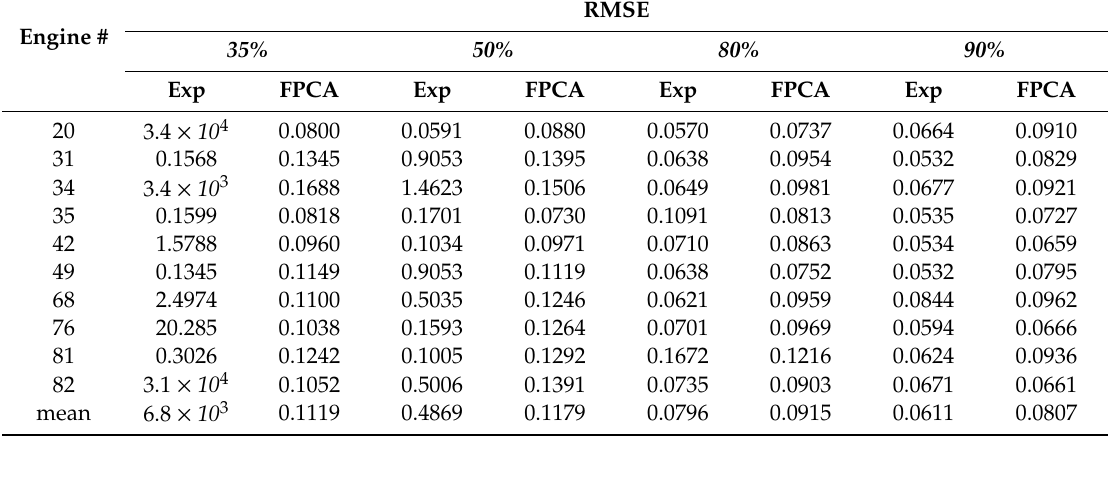
Table 5. Comparison of health prognostic results for the 10 testing engines.